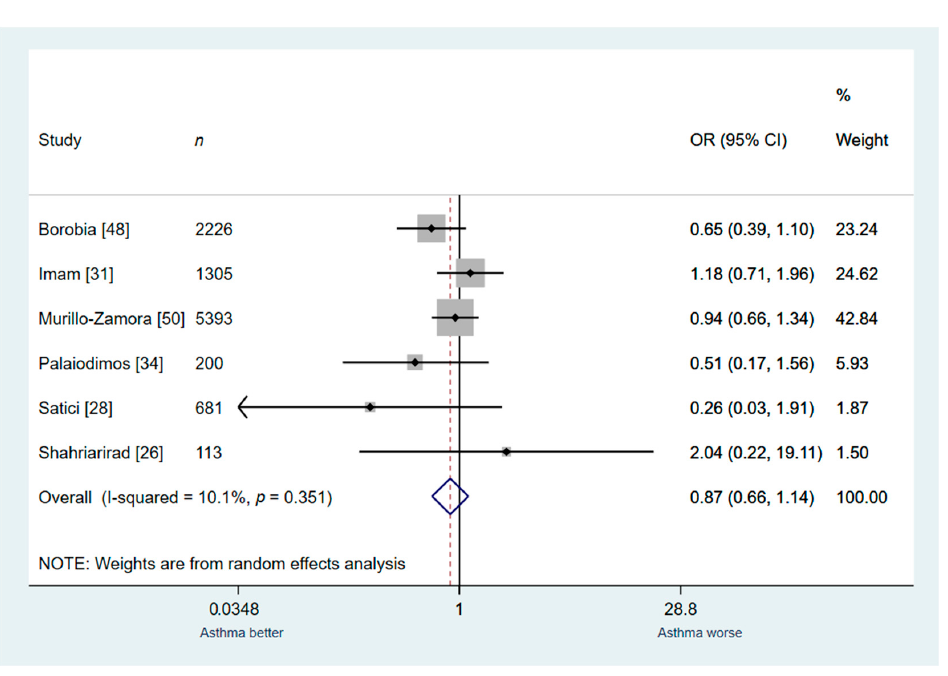
Table 3. Results of the meta ‐ regression analyses.